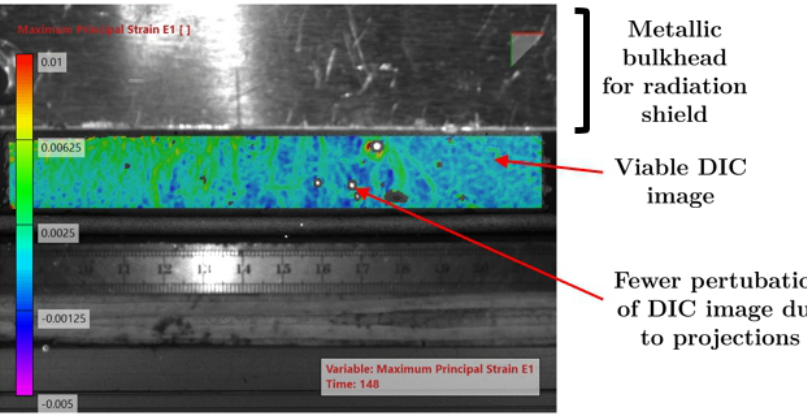
Figure 8. Principal strain calculated from the original image of Figure